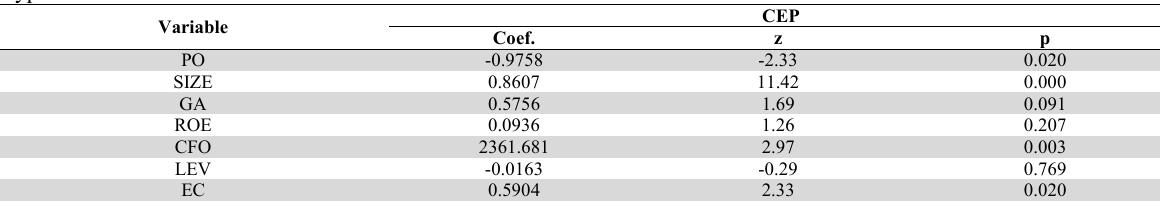
Hyphothesis 4 test